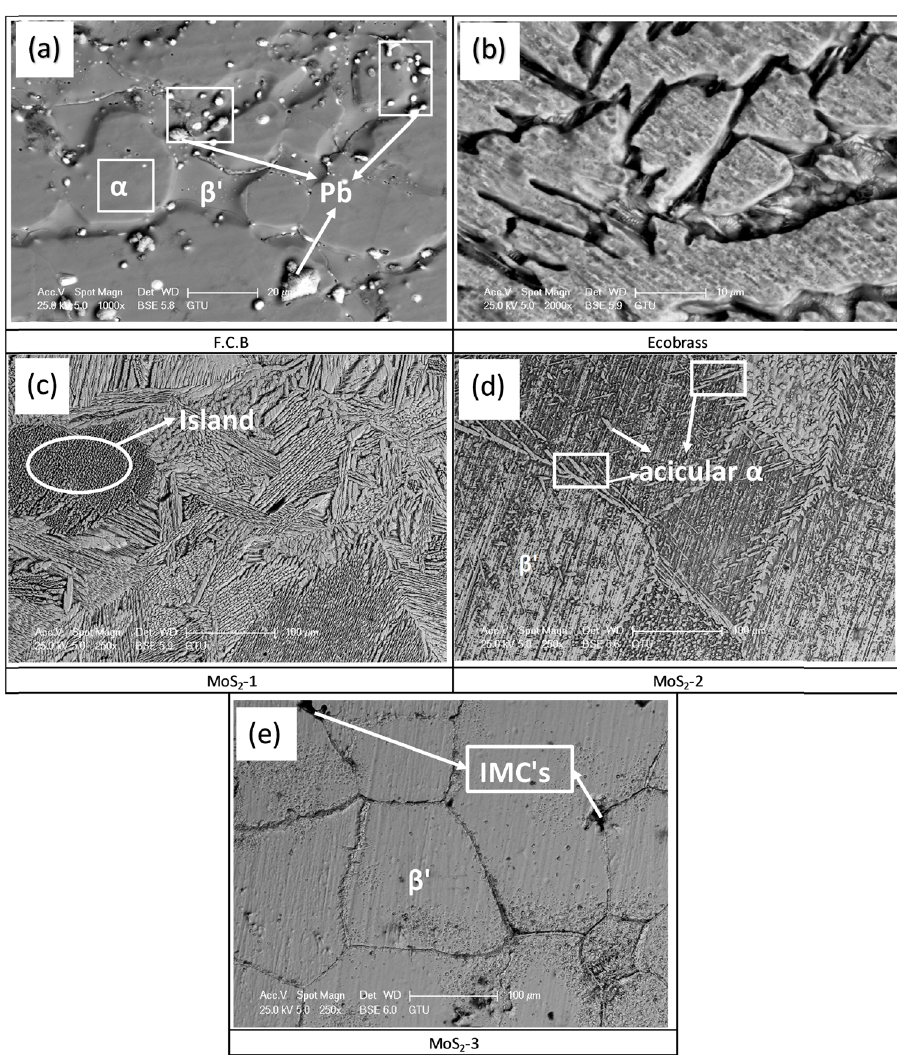
Figure 4: Micrographs of SEM under secondary electron images mode: ( a ) F.C.B; ( b ) Ecobrass; ( c ) MoS 2 - 1; ( d ) MoS 2 - 2; and ( e ) MoS 2 -